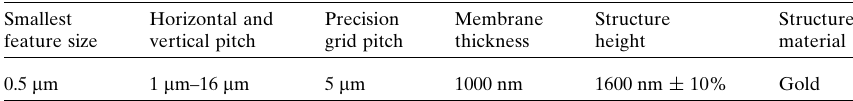
Table 2 Relevant parameters of the Xradia test pattern